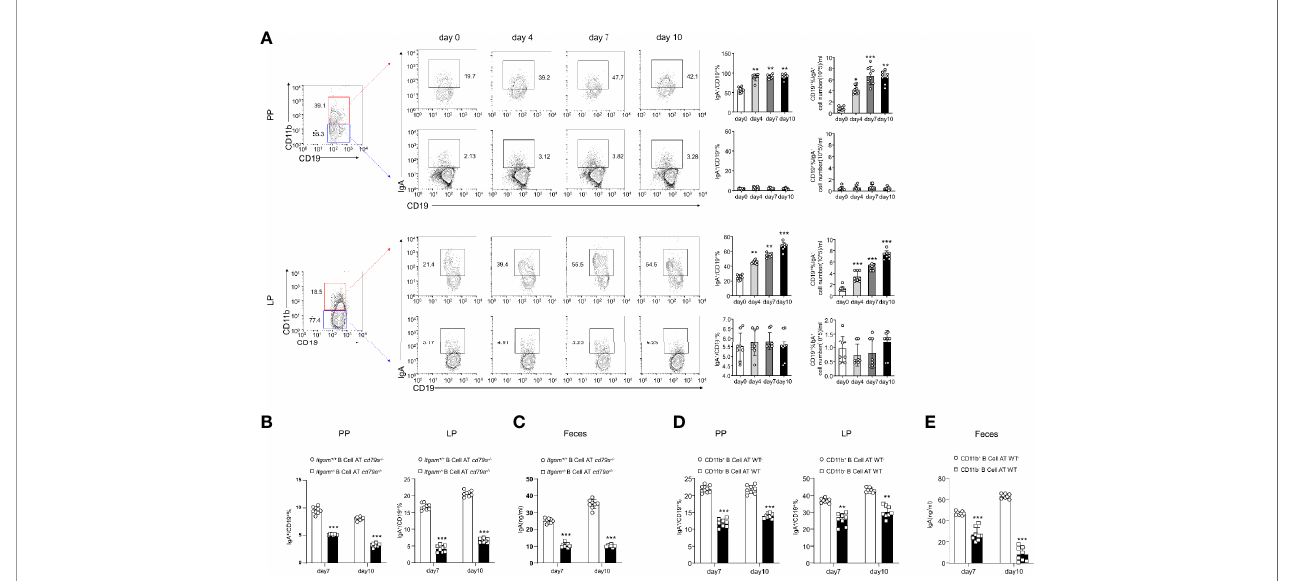
FIGURE 4 | B cells expressing CD11b contribute to the differentiation of IgA in mice with colitis. (A) Expression levels of IgA in CD11b + B cells and CD11b − B cells in the PPs and colorectal LP at days 0, 4, 7, and 10 after treatment with DSS were detected using fl ow cytometry. The frequency and absolute number of IgA-expressing cells are presented. (B) The adoptively transferred Itgam +/+ or Itgam − / − mice into Cd79a − / − mice were as described in Figure 1 . The percentage and absolute number of IgA + B cells in the LP and PPs from DSS-treated Cd79a − / − mice were analyzed using fl ow cytometry. (C) The supernatant of the mucus-containing fl uid was harvested and transferred into 10 mL phosphate-buffered saline (PBS), and the production of sIgA in the colon was determined using enzyme-linked immunosorbent assay (ELISA). (D) The adoptively transferred CD11b + and CD11b − B cells into WT mice were as described in Figure 1 . (E) The supernatant of the mucus-containing fl uid was harvested and transferred into 10 mL PBS, and the production of sIgA in the colon was determined using ELISA. **P < 0.01; ***P < 0.001. Data are expressed as mean ± SEM of six